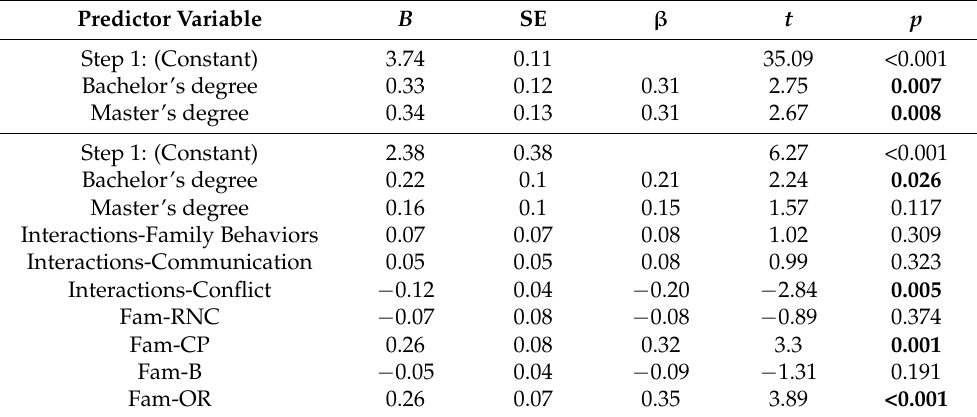
Table 3. Hierarchical Multiple Linear Regression Analysis for Predicting Staff Behavior ( N =